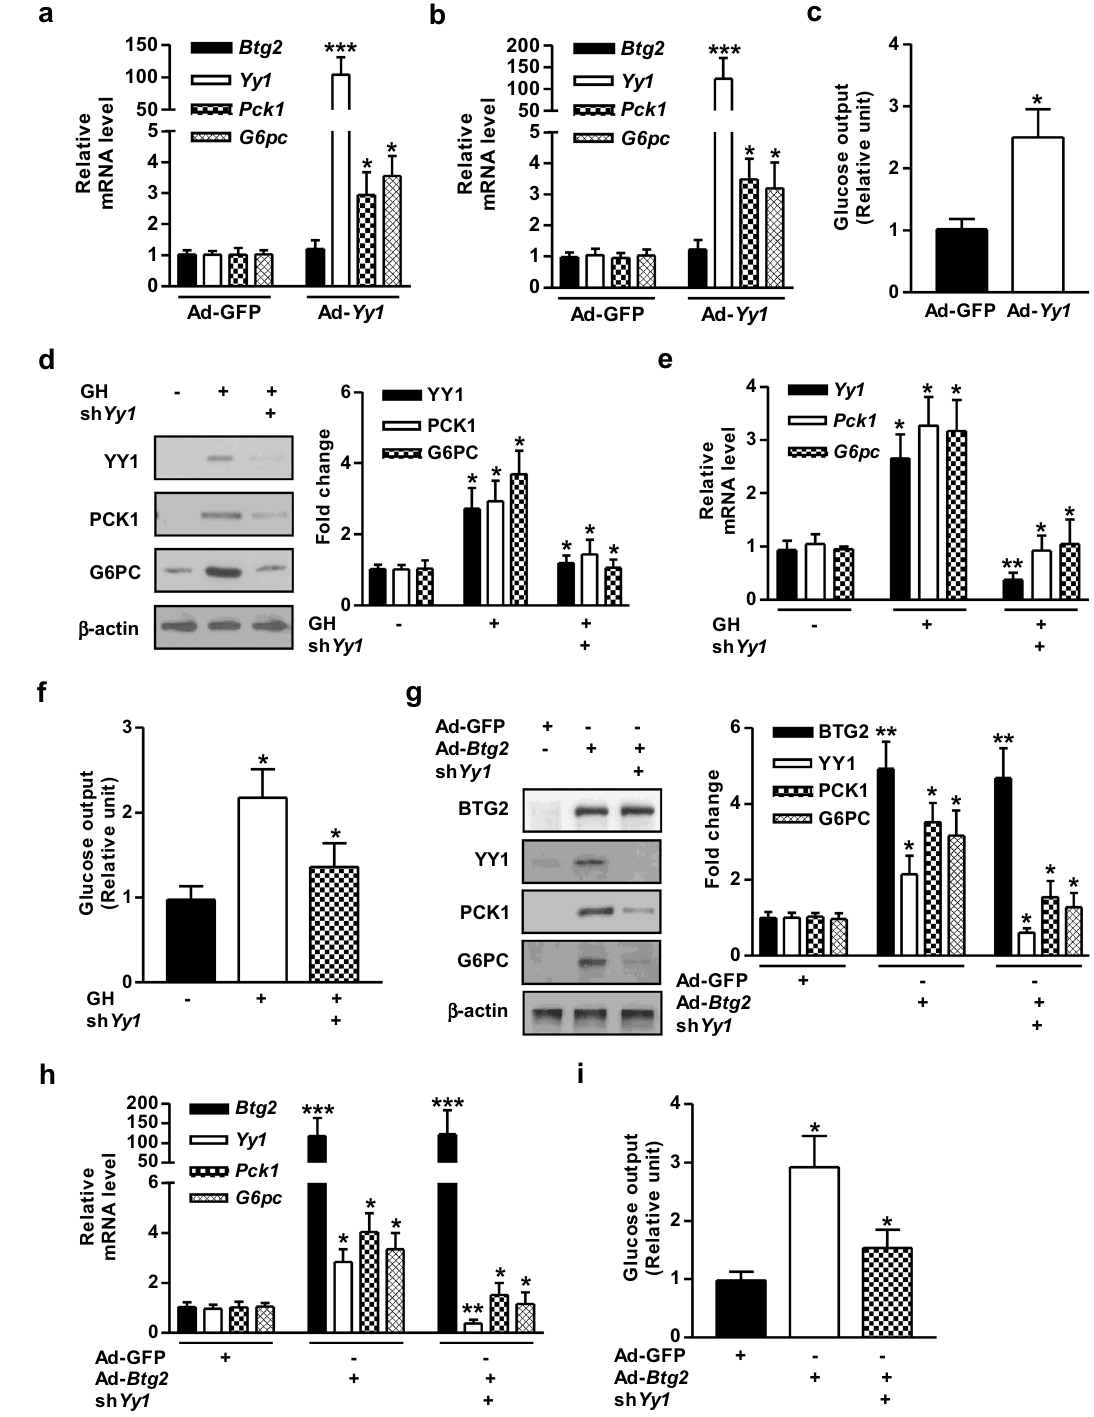
Figure 3. GH- and Btg2 -stimulated hepatic gluconeogenesis is mediated by YY1. ( a ) MPHs were infected with Ad-GFP and Ad- Yy1 at 60 MOI for 36 h. Gene expressions were analyzed by qPCR using gene-specific primers. ( b ) WT mice were injected with Ad-GFP and Ad- Yy1 via tail-vein for 7 days. Indicated gene expressions were analyzed by qPCR with specific primers. ( c ) Glucose production assay in MPH infected with Ad-GFP and Ad- Yy1 for 36 h. ( d ) MPHs were infected with lentiviral-sh Yy1 (sh Yy1 ) at 60 MOI for 36 h and followed by GH for 3 h. Total protein was isolated and analyzed using Western blot analysis with various antibodies. ( e ) MPHs were infected with lentiviral-sh Yy1 (sh Yy1 ) at 60 MOI for 36 h and then exposed with GH for 3 h. Total RNAs were utilized for qPCR analysis with indicated primers. ( f ) Glucose production assay in MPHs infected with sh Yy1 for 36 h, and then treated with GH for 3 h. ( g ) MPH were infected with Ad-GFP, Ad- Btg2 , and sh Yy1 at 60 MOI for 36 h. Whole cell extracts were analyzed using Western blot analysis with various antibodies. ( h ) MPHs were infected with Ad-GFP, Ad- Btg2 , and sh Yy1 at 60 MOI for 36 h. Quantitative PCR analysis was performed using gene-specific primers. ( i ) Glucose production assay was performed in MPHs infected with Ad-GFP, Ad- Yy1 , and sh Yy1 for 36 h. * P < 0.05, ** P < 0.01, and *** P < 0.001 vs. untreated control, Ad-GFP, GH-treated cells, or Ad- Btg2 -infected